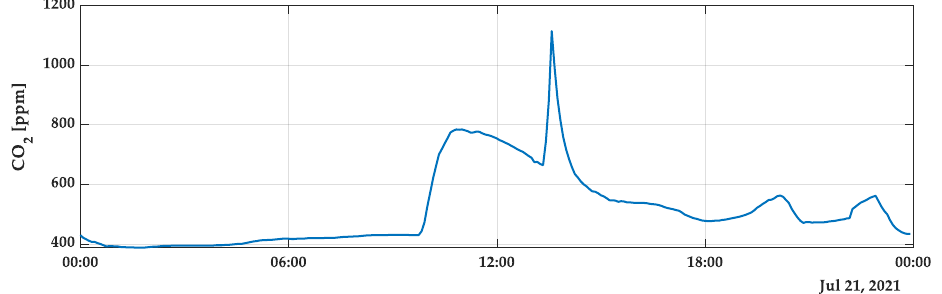
Figure 34. Records of CO 2 levels.